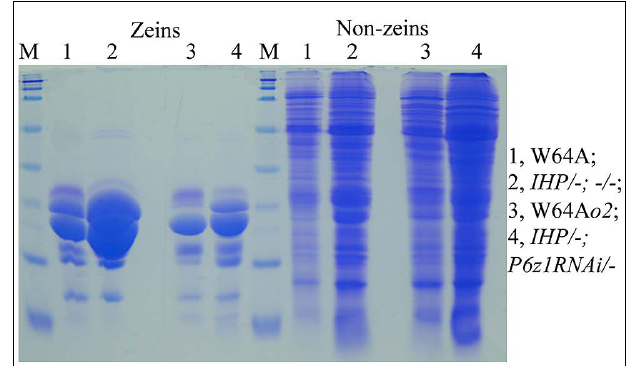
FIGURE 2 | Proteome rebalancing in o2 mutant and IHP with suppressed α -zeins. Lane 1 and 4,W64A andW64Ao2; lane 2 and 4, two F1 progeny of IHP × α -zeinRNAi/ − not inheriting and inheriting the RNAi. Adapted fromWu and Messing